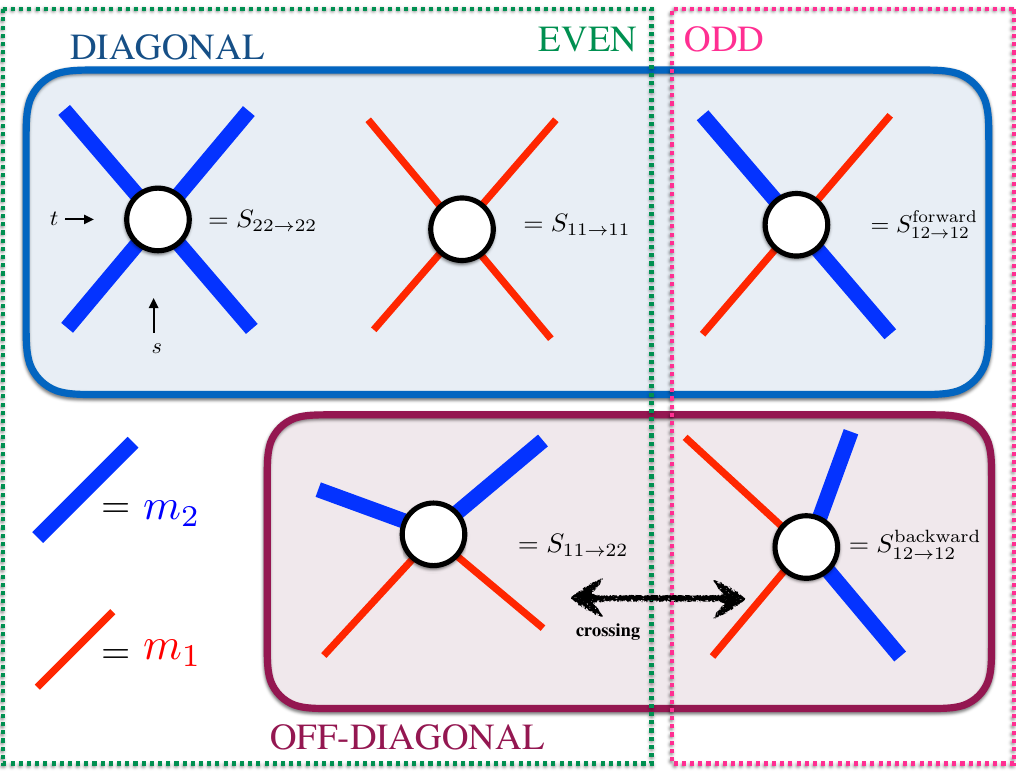
Figure 1. Diagonal processes are those where the incoming and outgoing particles have the same momenta as illustrated in the (cid:12)rst row; they are all crossing invariant. The non-diagonal processes in the second row are those for which the (cid:12)nal momenta are not the same as the initial momenta. Swapping space and time interchanges the odd and even o(cid:11)-diagonal processes so these o(cid:11)-diagonal processes play a crucial role in connecting these two sectors of di(cid:11)erent Z 2